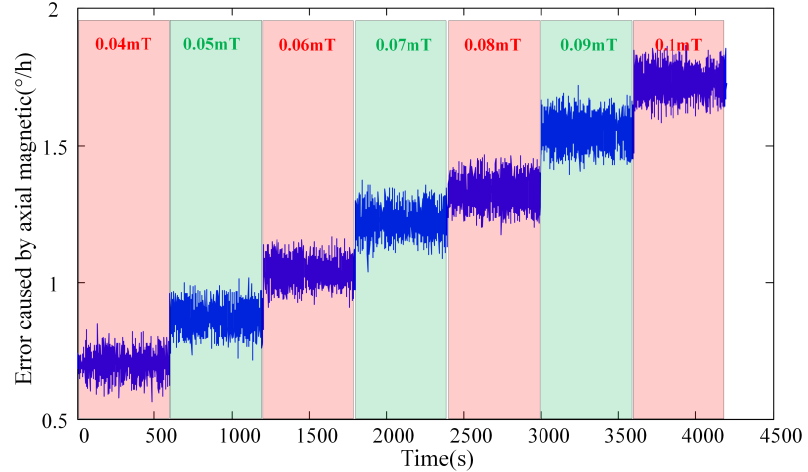
Figure 12. Experimental results of magnetic induction errors in axial magnetic field.